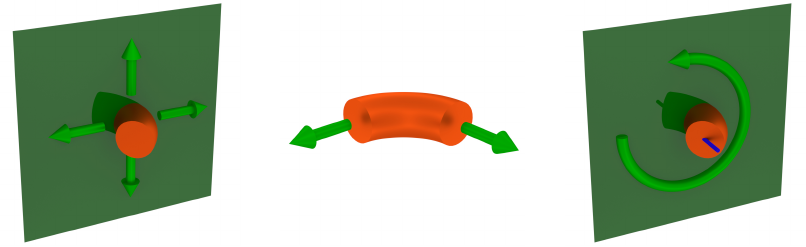
Figure 11. Modification